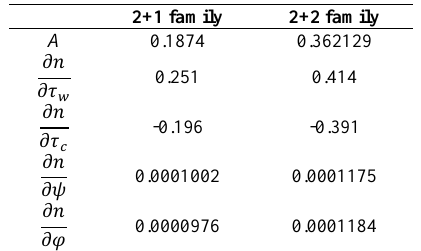
Table 2. The impact of fiscal instruments on the optimal number of